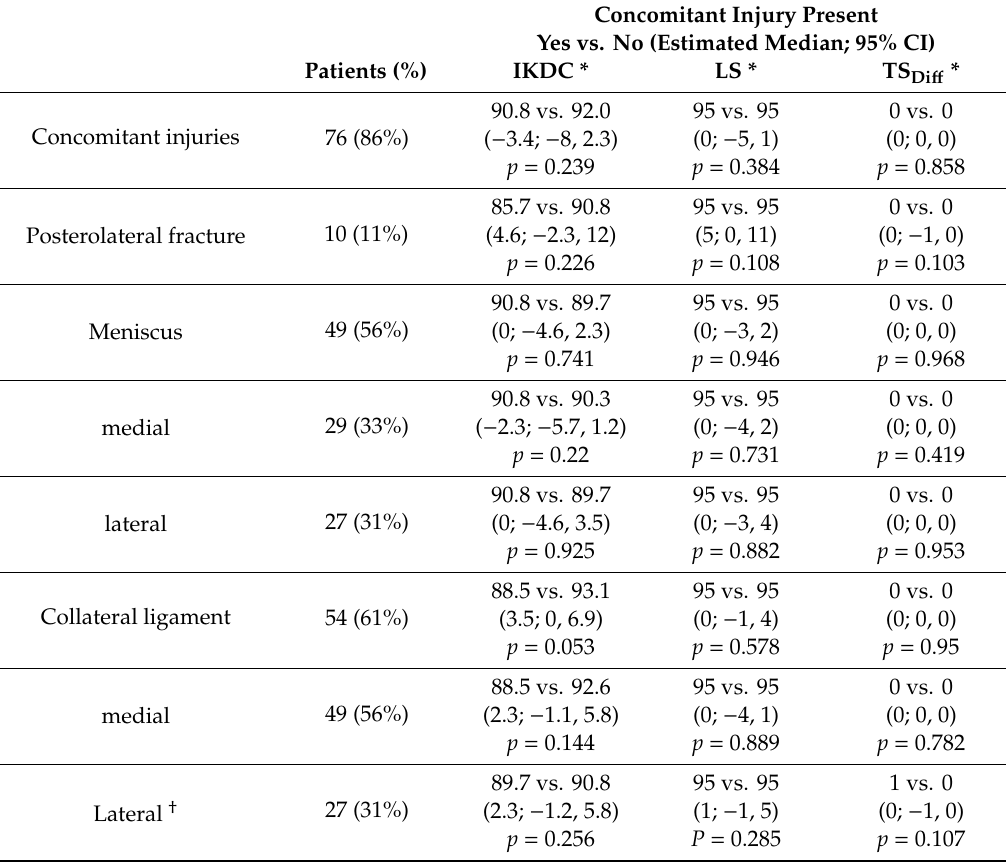
Figure 6. Completed arthroscopic ACL repair using suture augmentation (SA). Table 1. Concomitant injuries and their respective impact on the median postoperative functional outcome scores of the injured/non-injured patients.